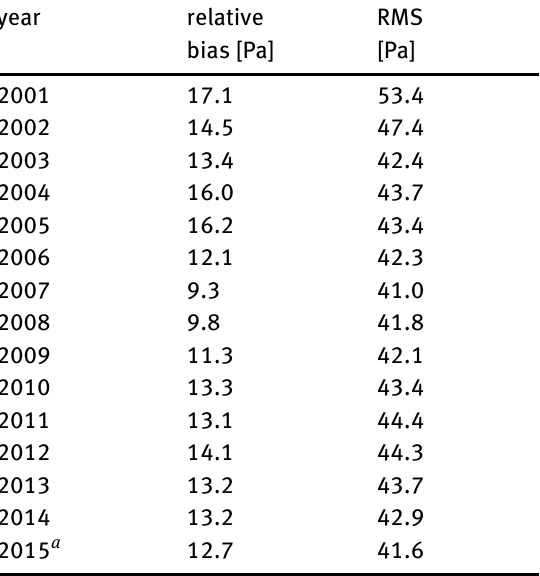
Table 1: Area-weighted global averages of 0.5 ∘ absolute values of relative biases as well as RMS of zero-centered residuals between surface pressure data sets at 6-hourly resolution for individual years between 2001 and 2015 from operational ECMWF analyses and ERA-Interim reanalyses, both reduced to the same reference